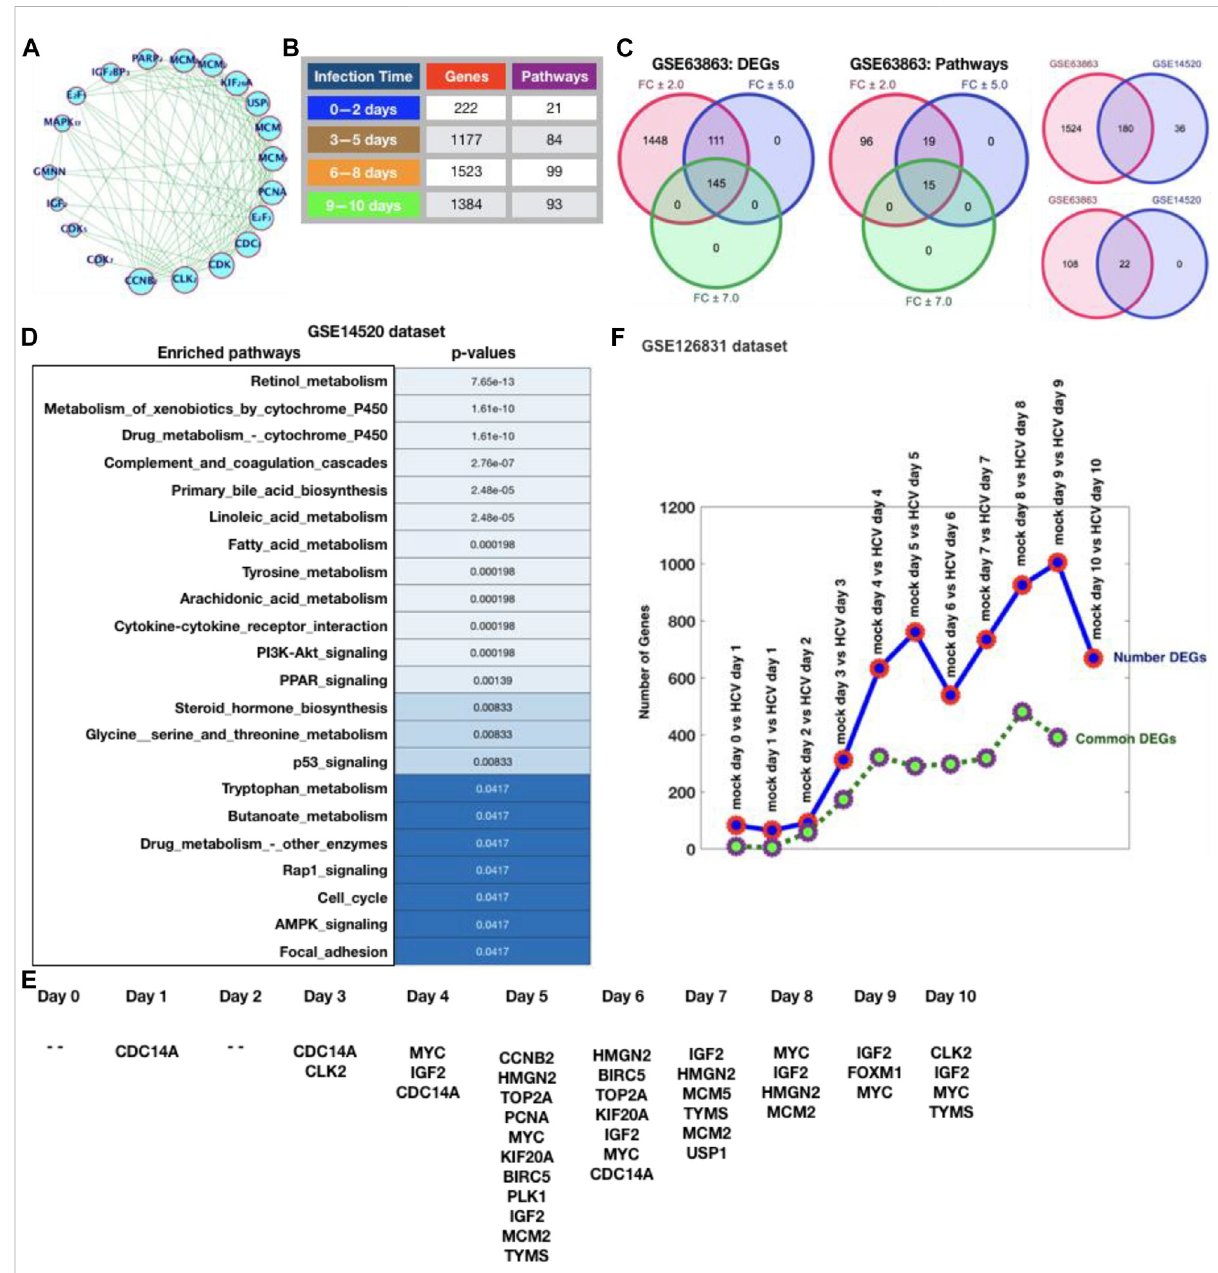
FIGURE 1 Differentialgeneexpressionpro fi lingandpathwayenrichmentanalysis. (A) Co-occurrencenetwork. (B) Temporalevolutionofgeneexpression aberrationsanditsfunctionalconsequences. (C) Venndiagramtorepresentthesharedandspeci fi cgenesandpathwayswhicharepotentiallyaltered as a result of CRC. (D) Enriched pathways followed by their respective p -values. (E) Temporal gene expression pro fi ling of HCC in result to HCV infection. The number of DEGs from day 1 to day 10 and number of common DEGs in different combinations (such day 1 with day 2, day 2 with day 3, day 3 with day 4, day 4 with day 5, and so on). (F) HCC biomarkers pro fi ling for the temporal